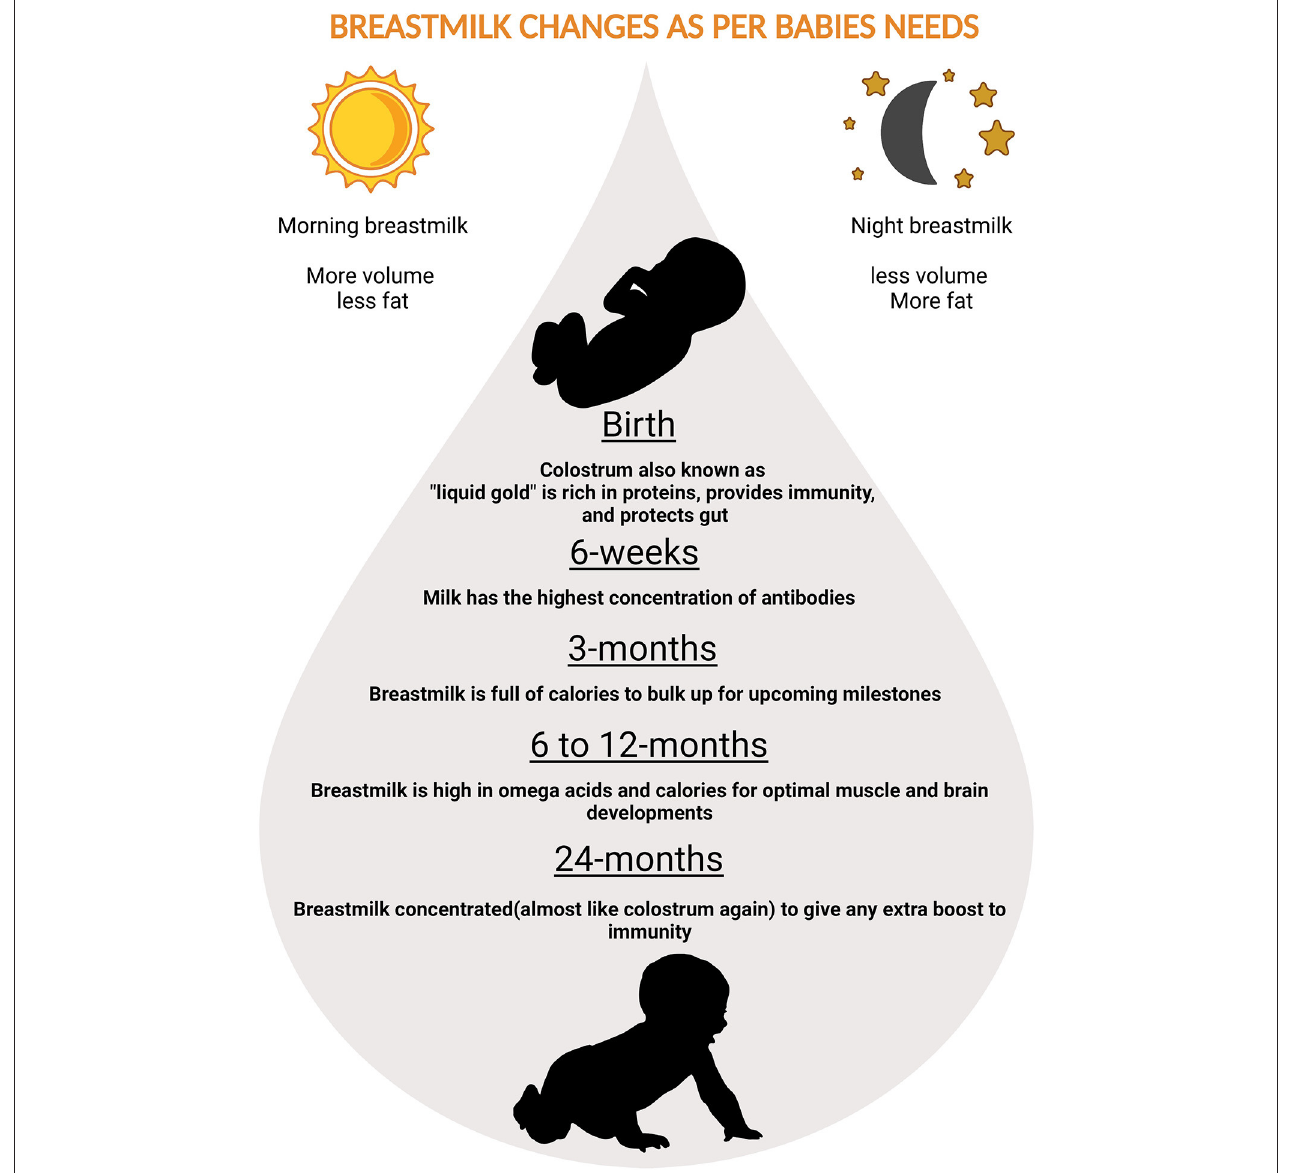
FIGURE 2 | Magical ways in which breastmilk changes to adapt to babies needs.